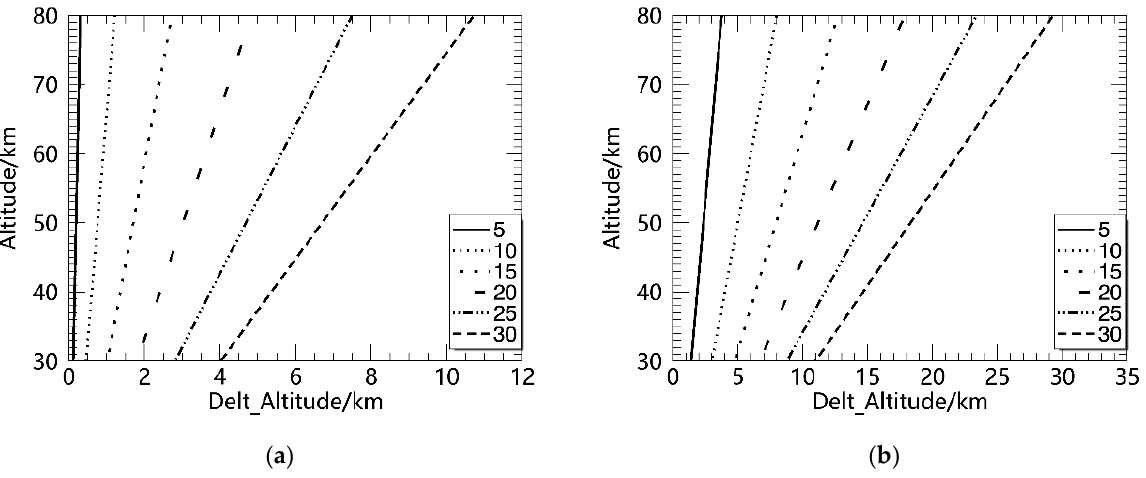
Figure 4. (a) The deviation in altitude when the settled observation angle is 0° and the roll amplitude is increased from 5° to 30° in 5° intervals within 30-80 km. (b) The deviation in altitude when the is increased from 5 ◦ to 30 ◦ in 5 ◦ intervals within 30–80 km. ( b ) The deviation in altitude when the settled observation angle is 30° and the roll amplitude is increased from 5° to 30° in 5° intervals settled observation angle is 30 ◦ and the roll amplitude is increased from 5 ◦ to 30 ◦ in 5 ◦ intervals within 30-80 km. within 30–80